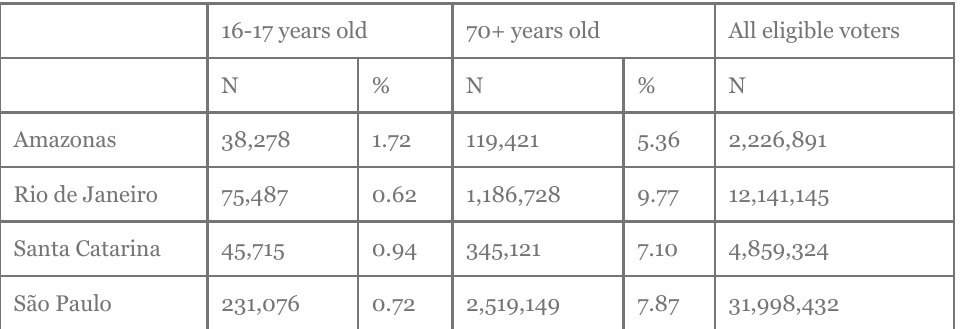
Table 1: Eligible voters in Brazil for whom voting is not compulsory, by age 16-17 years old 70+ years